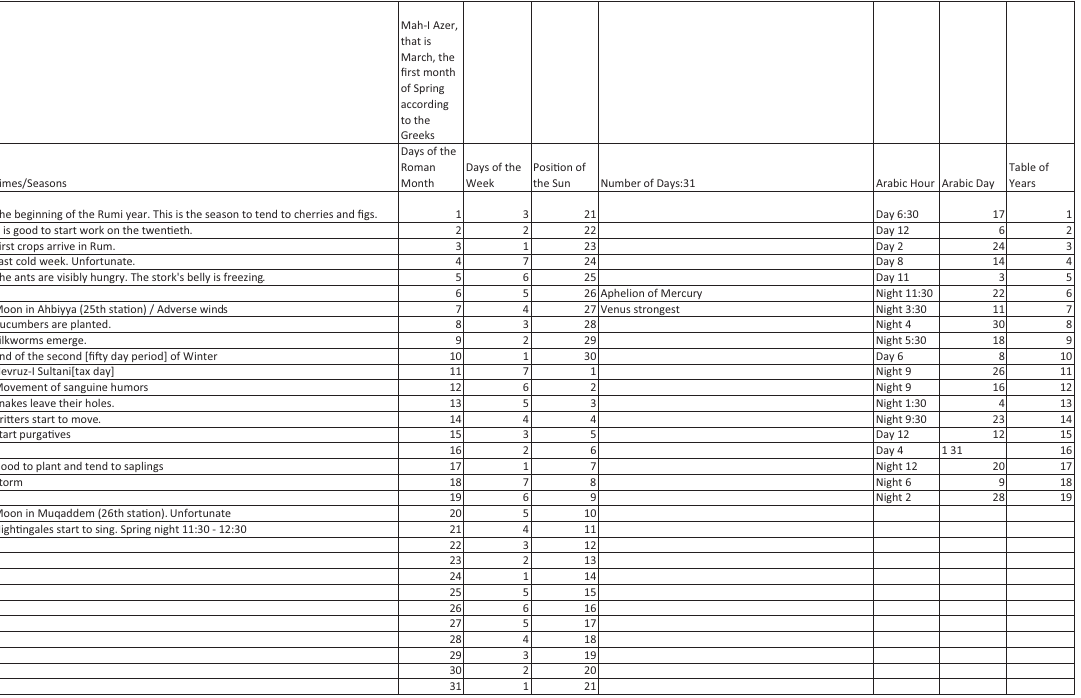
Figure 1: Partial Translation of Anonymous Ruzname, Milli Yazmalar FB380,